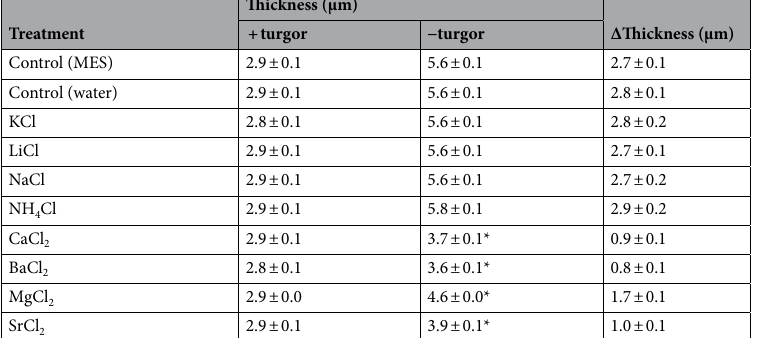
Table 1. Effects of selected chloride salts on the thickness and swelling (Δthickness) of anticlinal epidermal cell walls of excised skin segments (ES) of ‘Sam’ sweet cherry fruit before (+ turgor) and after turgor release (−turgor) by a freeze/thaw cycle. The ES were incubated in salt solutions at concentrations of 10 mM buffered with 10 mM MES. The pH was adjusted to pH 5.8 using KOH or HCl. Buffer only (10 mM MES, pH 5.8) and deionized water served as the controls. ΔThickness was calculated as the difference between cell wall thickness measured after turgor release, minus that measured before turgor release. Data are means ± SE. *Mean separation within columns against the MES control indicated by *, Dunnett test at p <